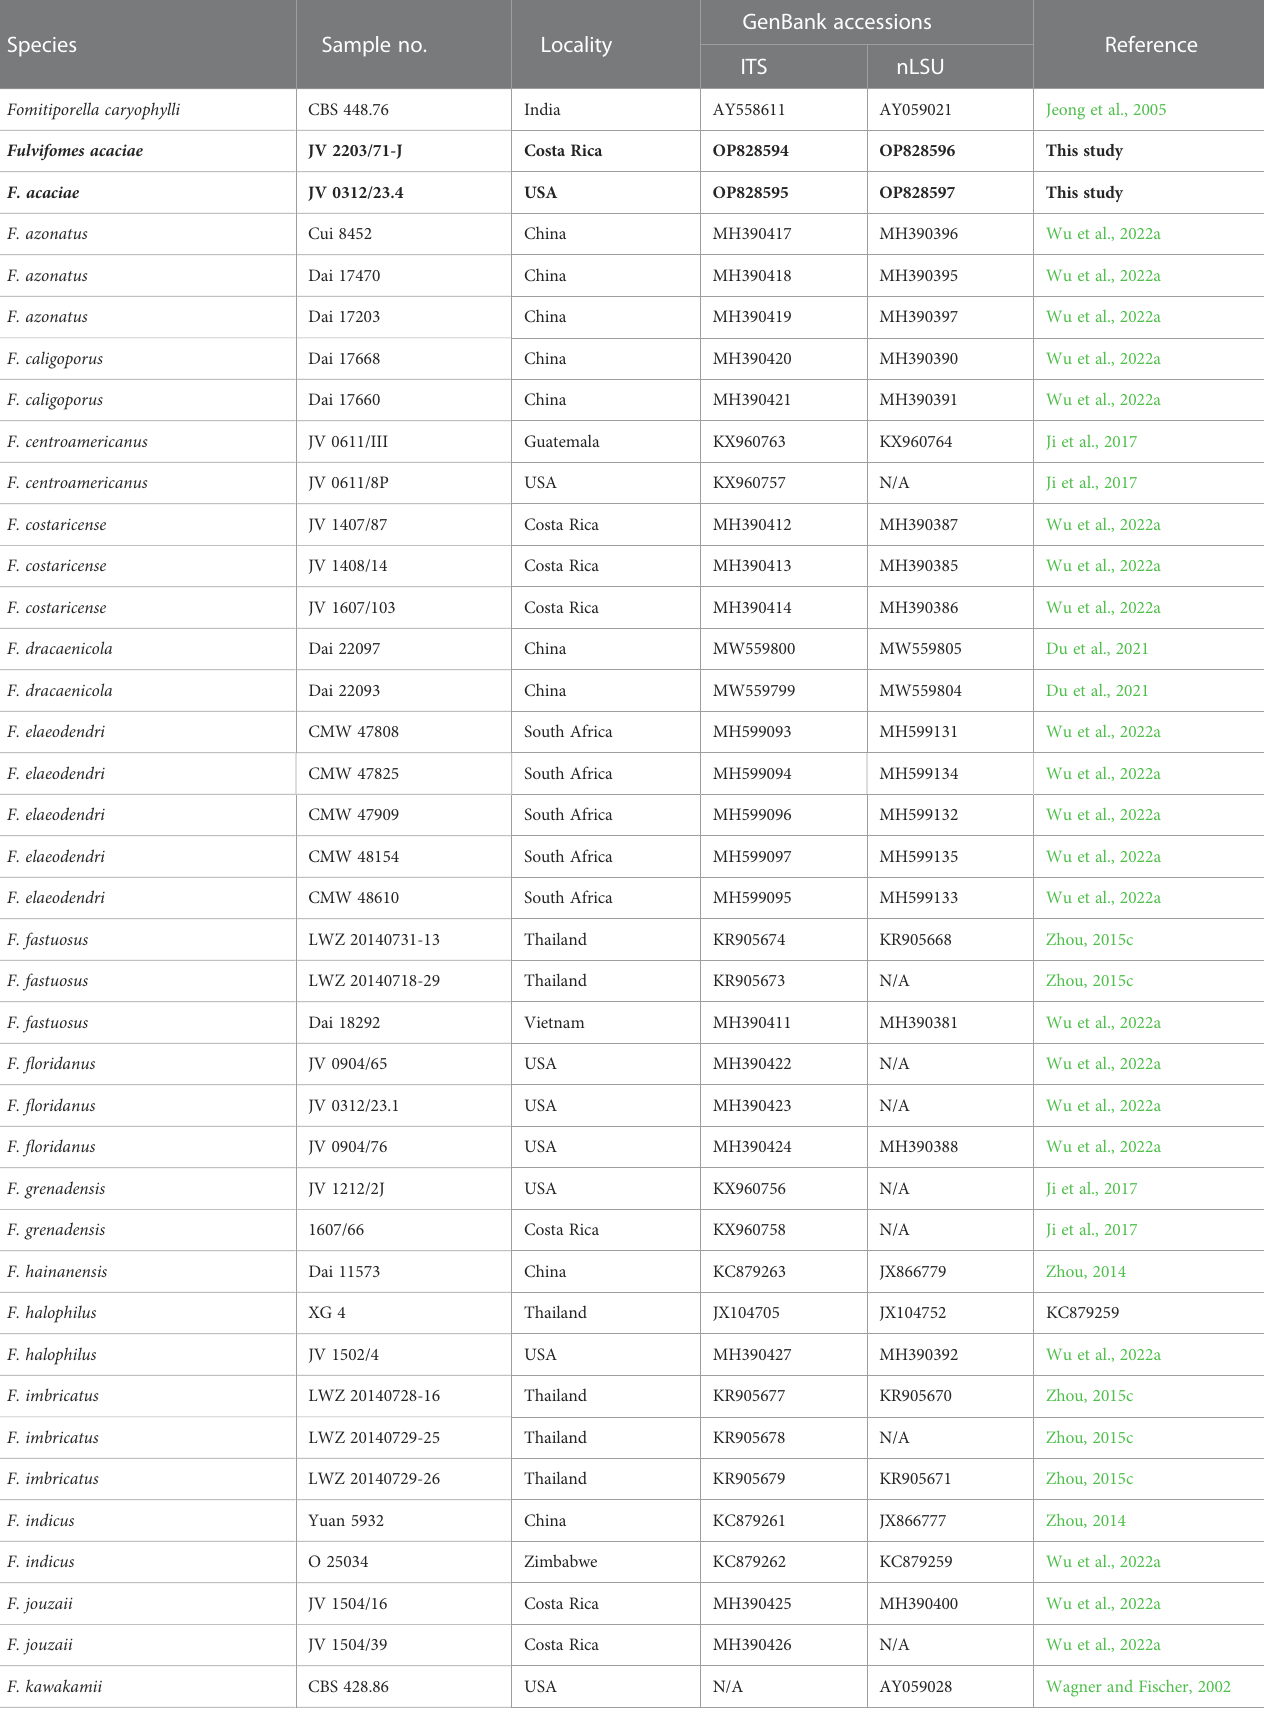
TABLE 1 Taxa, voucher specimens, and GenBank accession numbers of sequences used in the phylogeny of Fulvifomes .